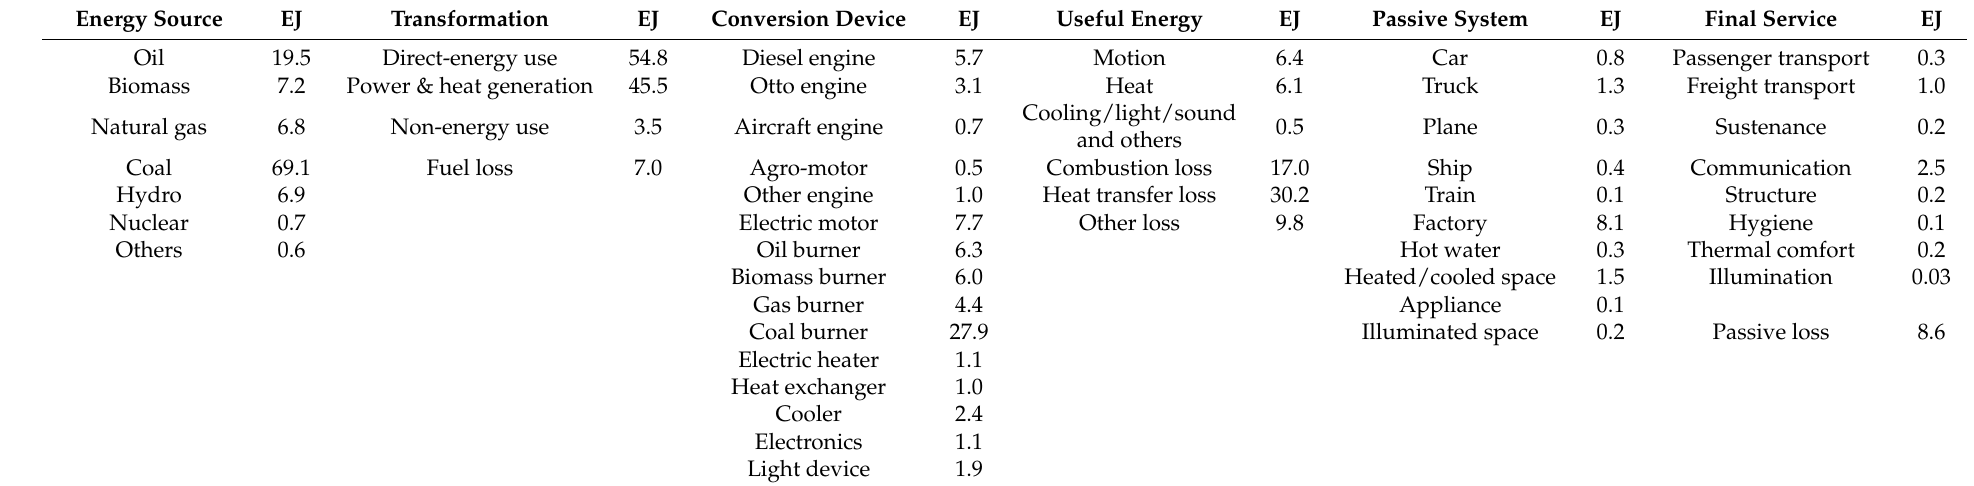
Table A2. Vertical slices of exergy flow of China in